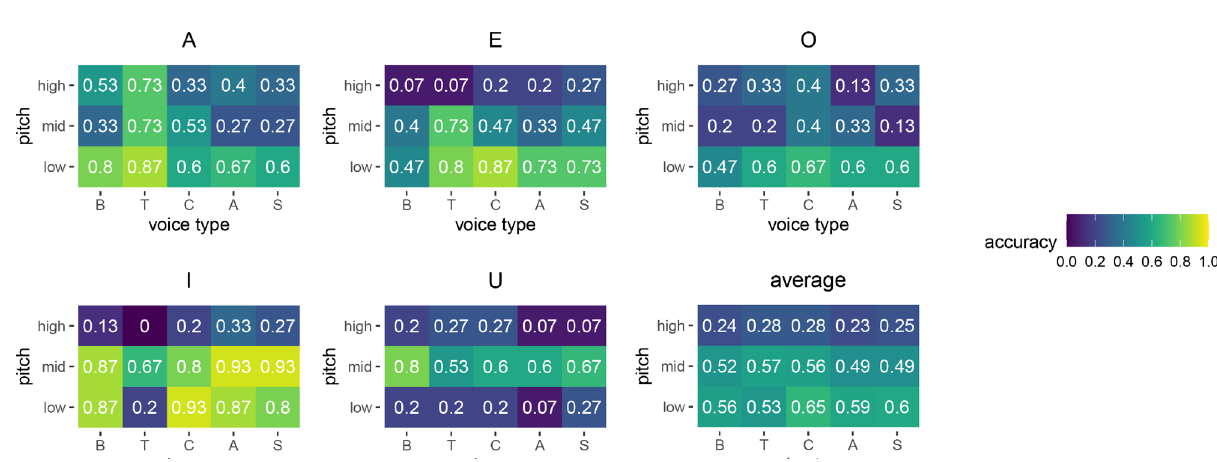
Figure 5. Labeling accuracy of the five vowel sets for different voice types: Bass (B), Tenor (T), Countertenor (C), Alto (A), Soprano (S). In the lower right corner, the accuracy is averaged across